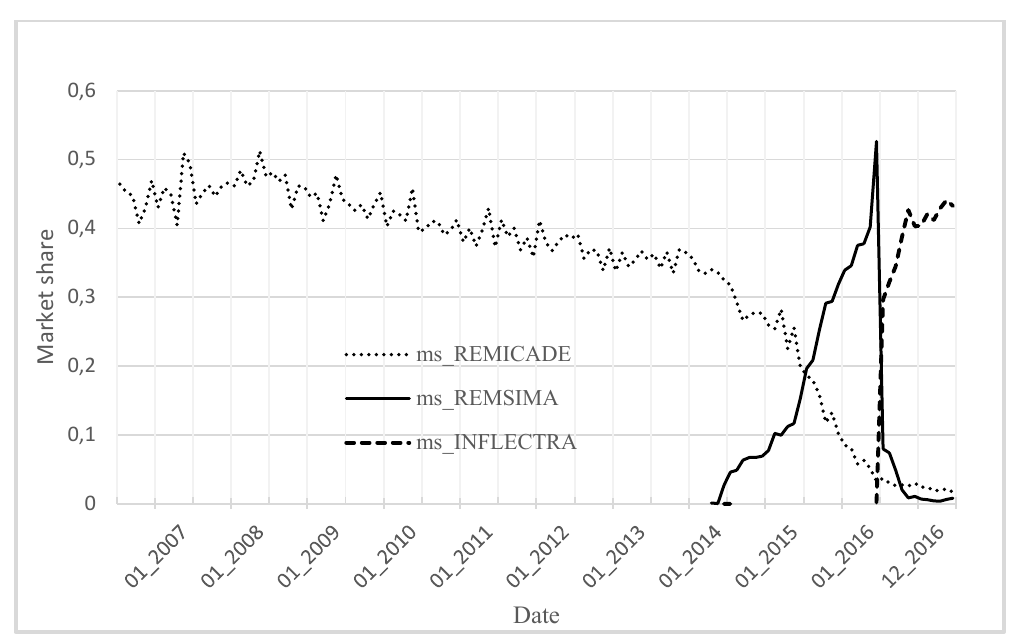
Figure 2: Market shares of Remicade (original brand) and the two biosimilars per